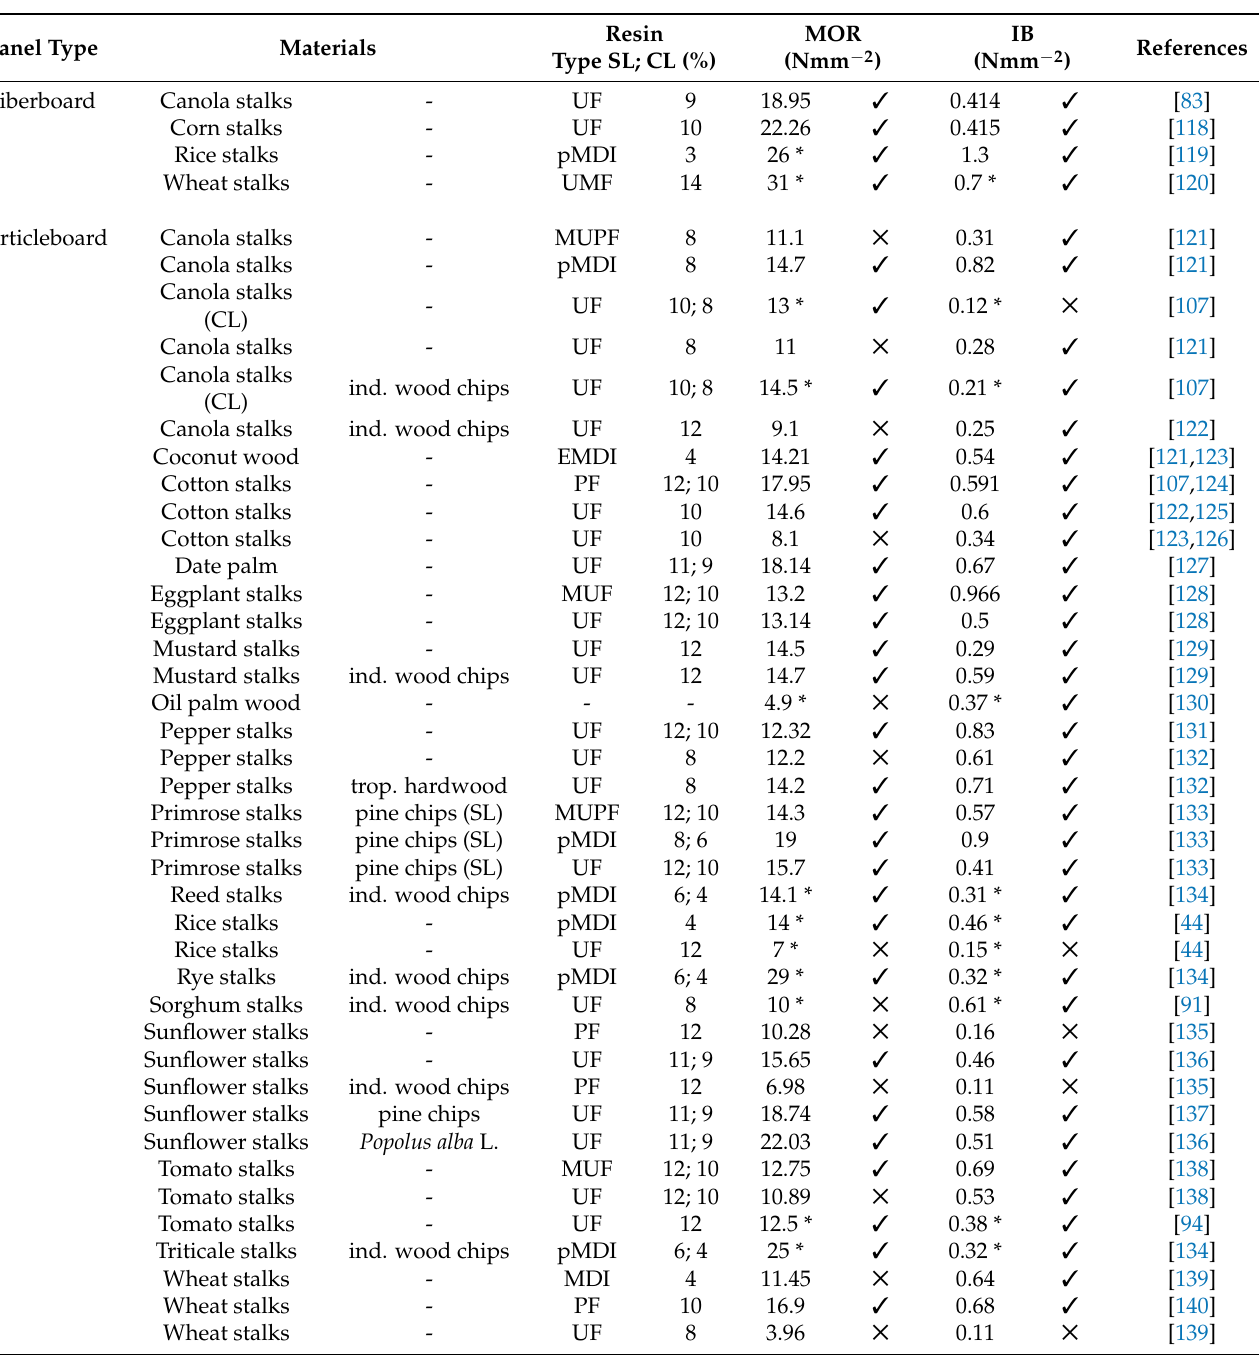
Table 7. Harvest residues used for panel production with information on whether MOR and IB meet ( (cid:51) ) or not ( (cid:53) ) the standard requirements (fiberboard EN 622-3:2004; particleboard EN